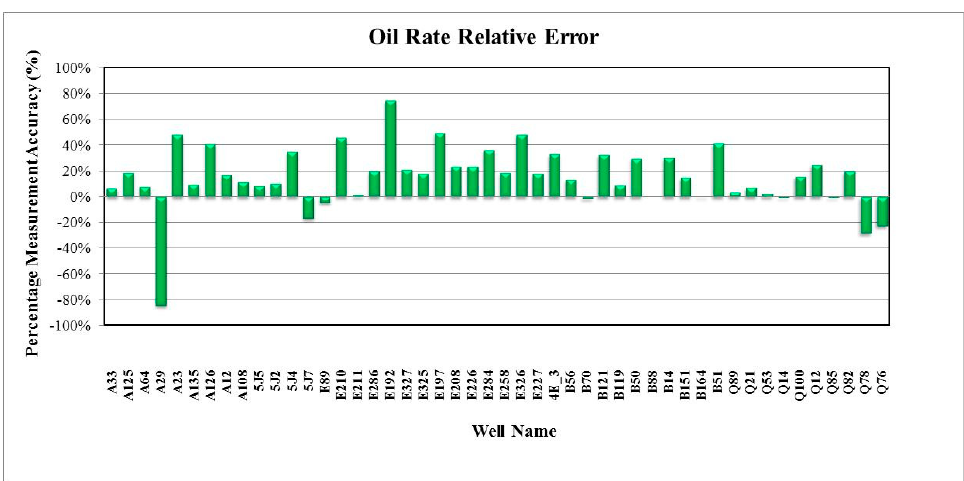
Figure 22. Gas rate measurement accuracy using the Darcy correlation.